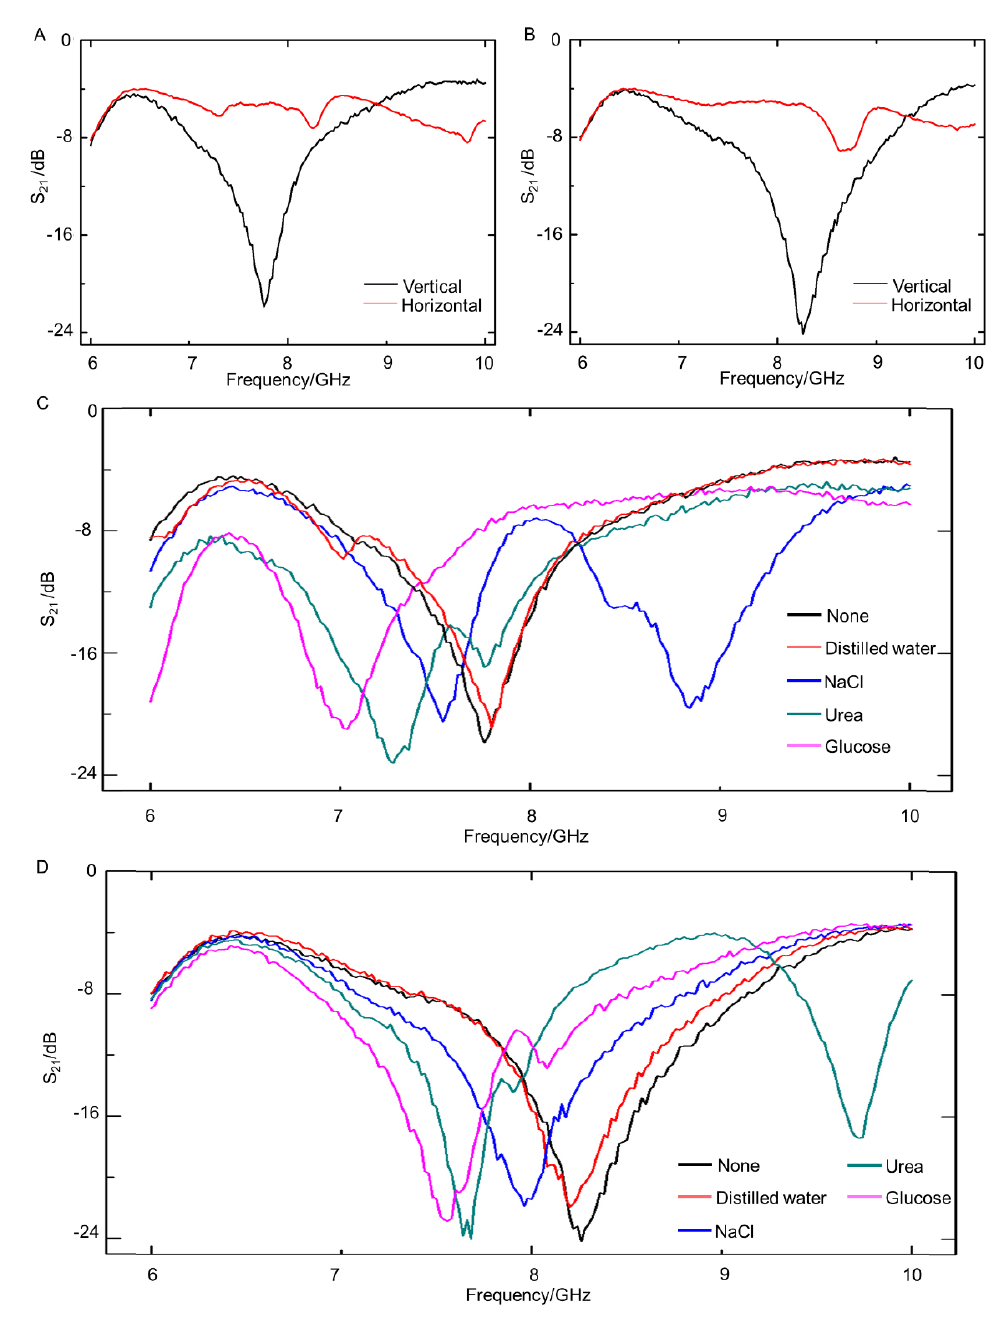
Figure 6. The sensing performance of liquid-metal metamaterials: ( A ) the S 21 parameters of DSRR-based metamaterials in vertical and horizontal positions; ( B ) the S 21 parameters of ESRR-based metamaterials in vertical and horizontal positions; ( C ) the S 21 parameters of DSRR-based metamaterials when deposited by different substances; (D) the S 21 parameters of ESRR-based metamaterials when deposited by different substances.